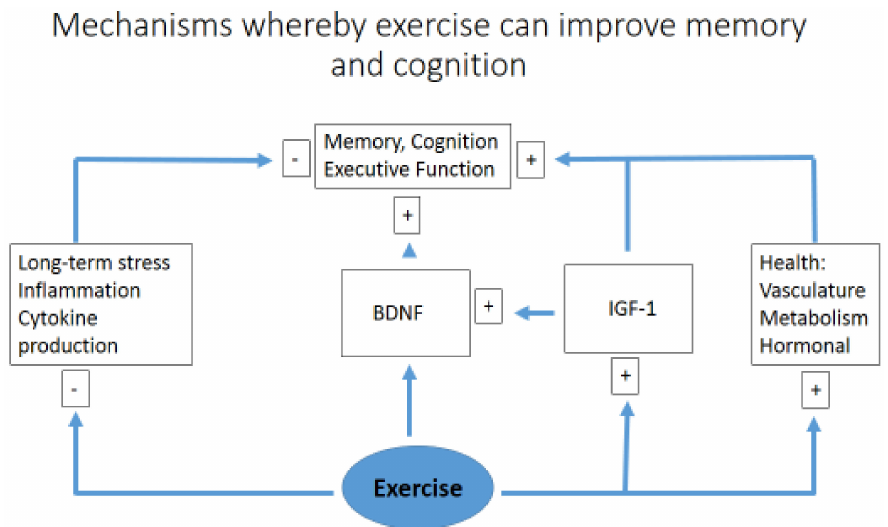
Figure 2. A simplified diagram of how exercise may simultaneously improve memory and cognition. Brain-derived neurotrophic factor (BDNF); insulin-like growth factor 1